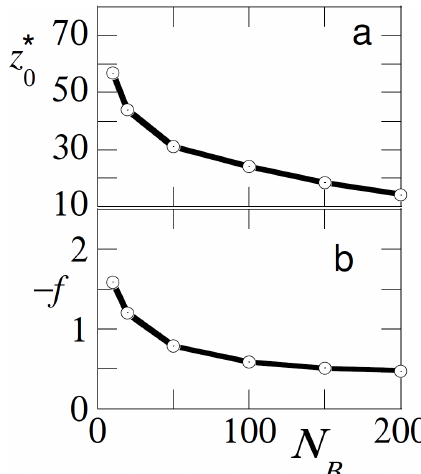
Figure 5. ( a ) Detachment distance z ∗ length of the free chains N B . Parameters: N A = 200, χ SA = χ SB = − 6, ϕ b